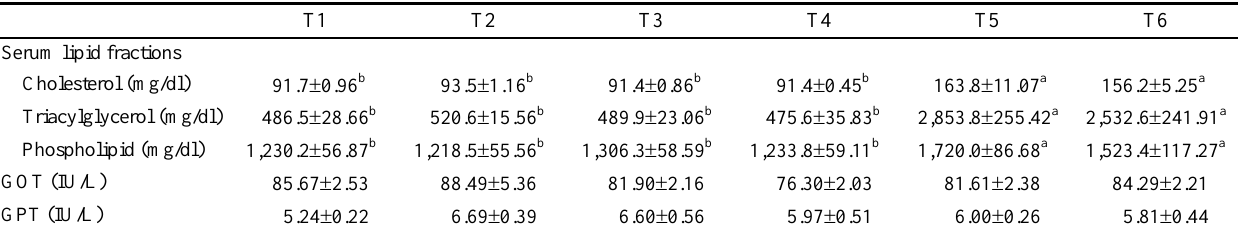
Table 4. Effects of various treatments for inducing fatty acid hemorrhagic syndrome on serum lipid fractions and enzyme activities in immature laying-type male chicks